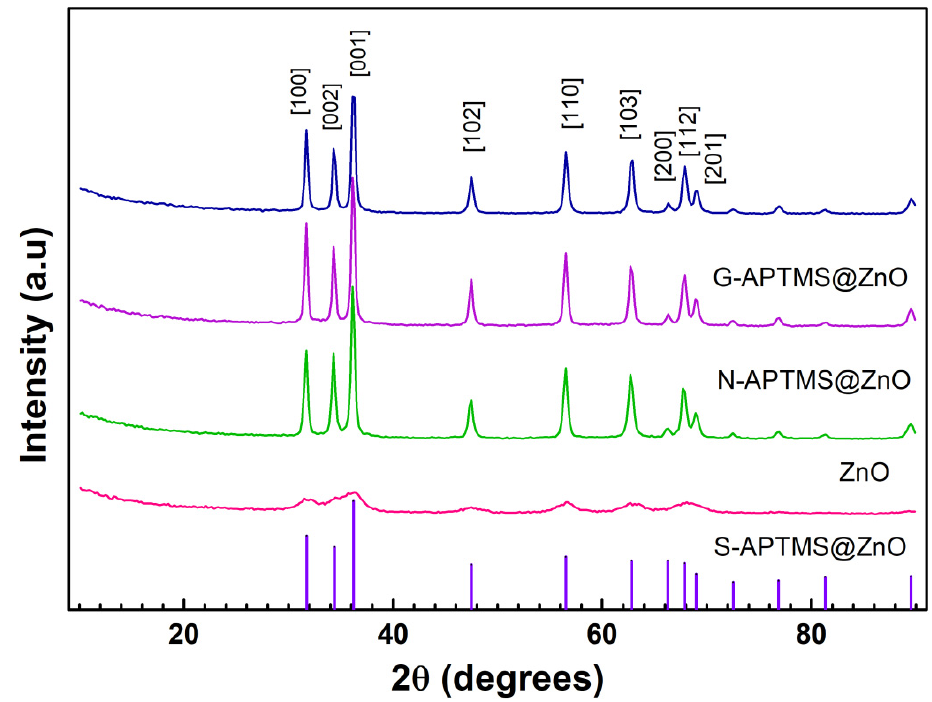
Figure 1. XRD pattern of ZnO and the coated samples N-APTMS@ZnO, G-APTMS@ZnO, and S-APTMS@ZnO. The violet vertical lines represent reflexes from the JCPDS 73-1520 reference card of hexagonal ZnO. The planes indexes are also reported.